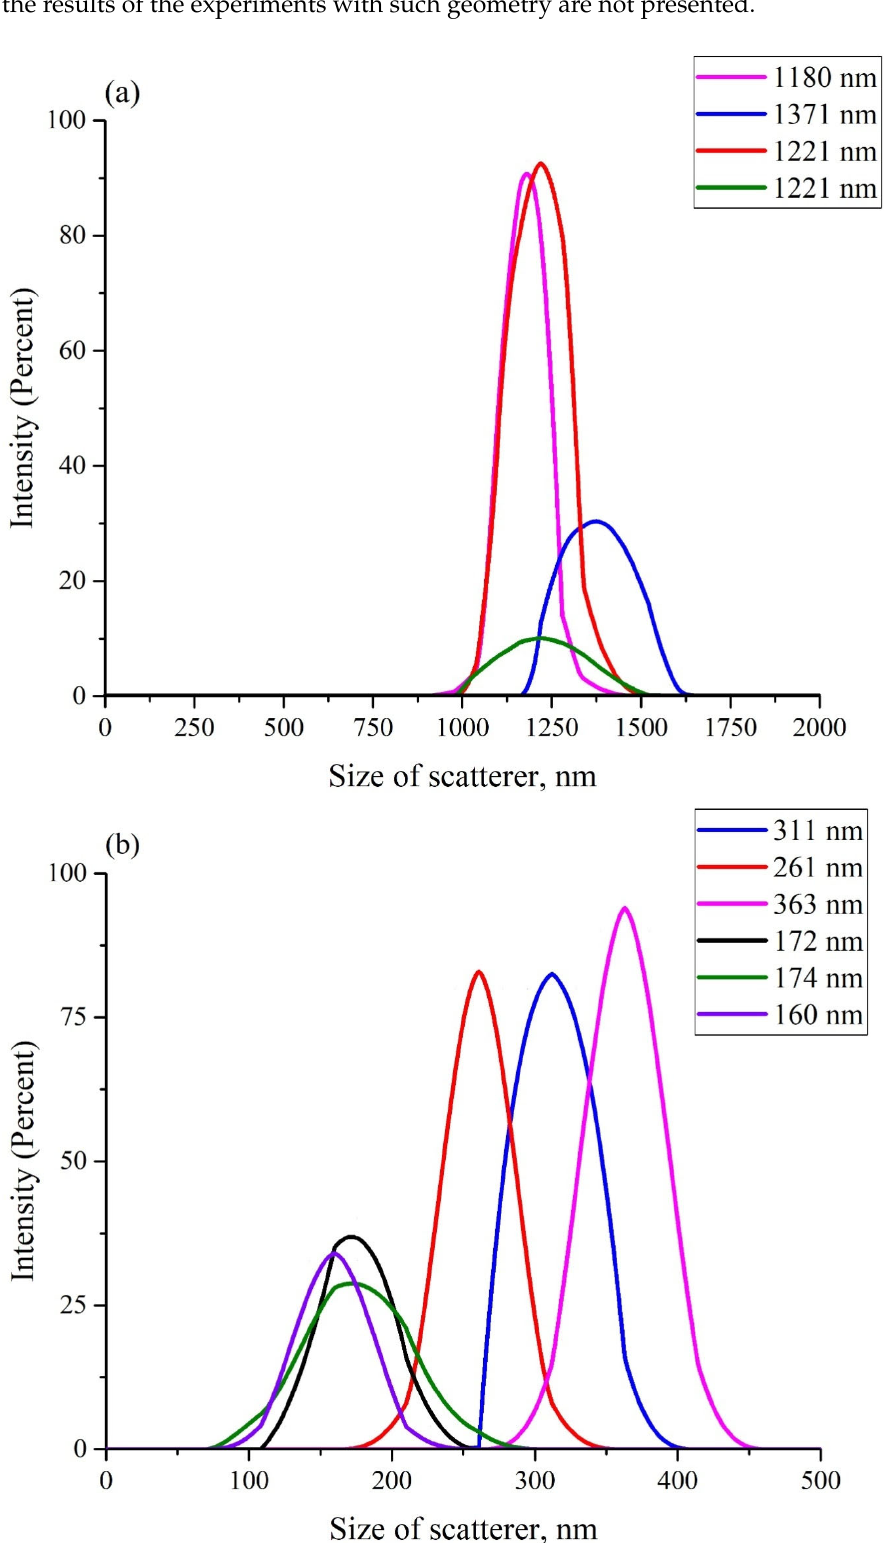
Figure 3. The distributions of scattering intensity over the sizes of the scatterers. Panel ( a )—ordinary water. Panel ( b )—DDW.